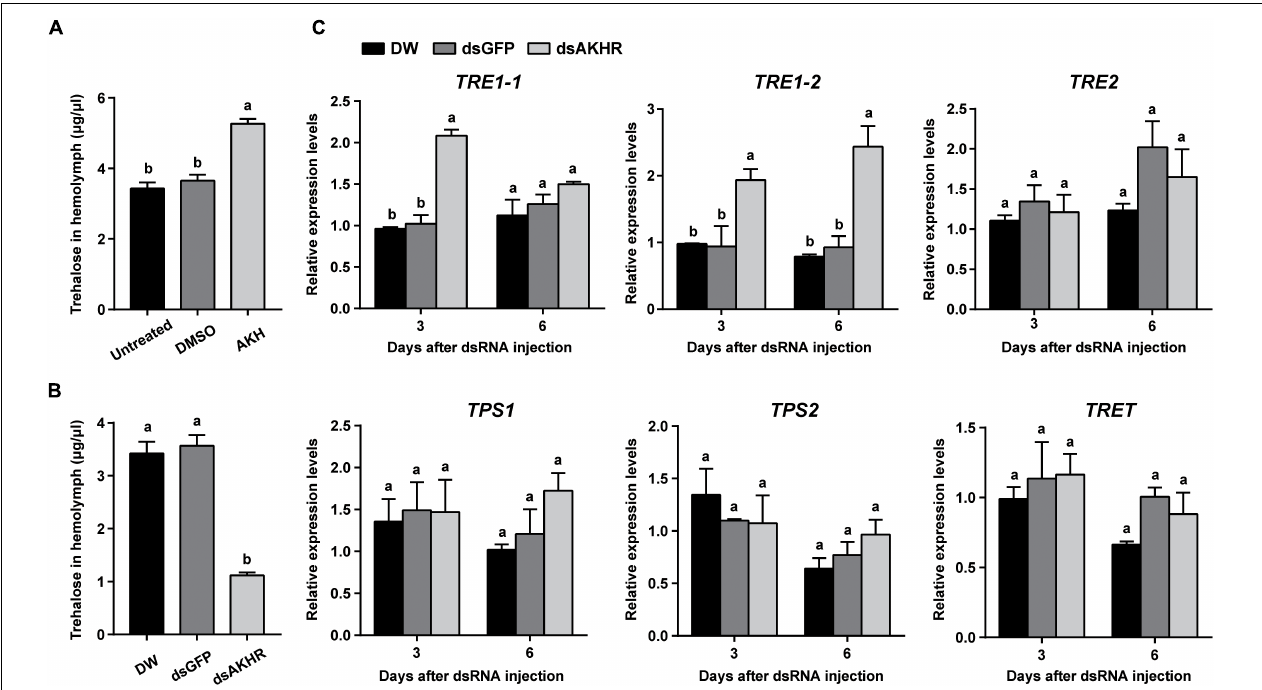
FIGURE 3 | NlAKHR knockdown decreases hemolymph trehalose levels and affects the expression of trehalose metabolism-related genes. Three-day-old females were injected with 20 pmol of Nl AKH or the same volume of DMSO (control). (A) Hemolymph was collected 90 min later and trehalose levels were determined. Newly emerged females were injected with DEPC-treated water (DW) or dsRNA for NlAKHR or GFP (control) genes. (B) Hemolymph trehalose levels were determined on the 3rd day after dsRNA injection. (C) Relative expression levels of trehalose metabolism-related genes were determined by qPCR on the 3rd and 6th day after dsRNA injection. The results are represented as means ± SE from three independent experiments. Different lowercase letters above the columns represent significant difference at P < 0.05 using one-way ANOVA followed by Duncan’s multiple